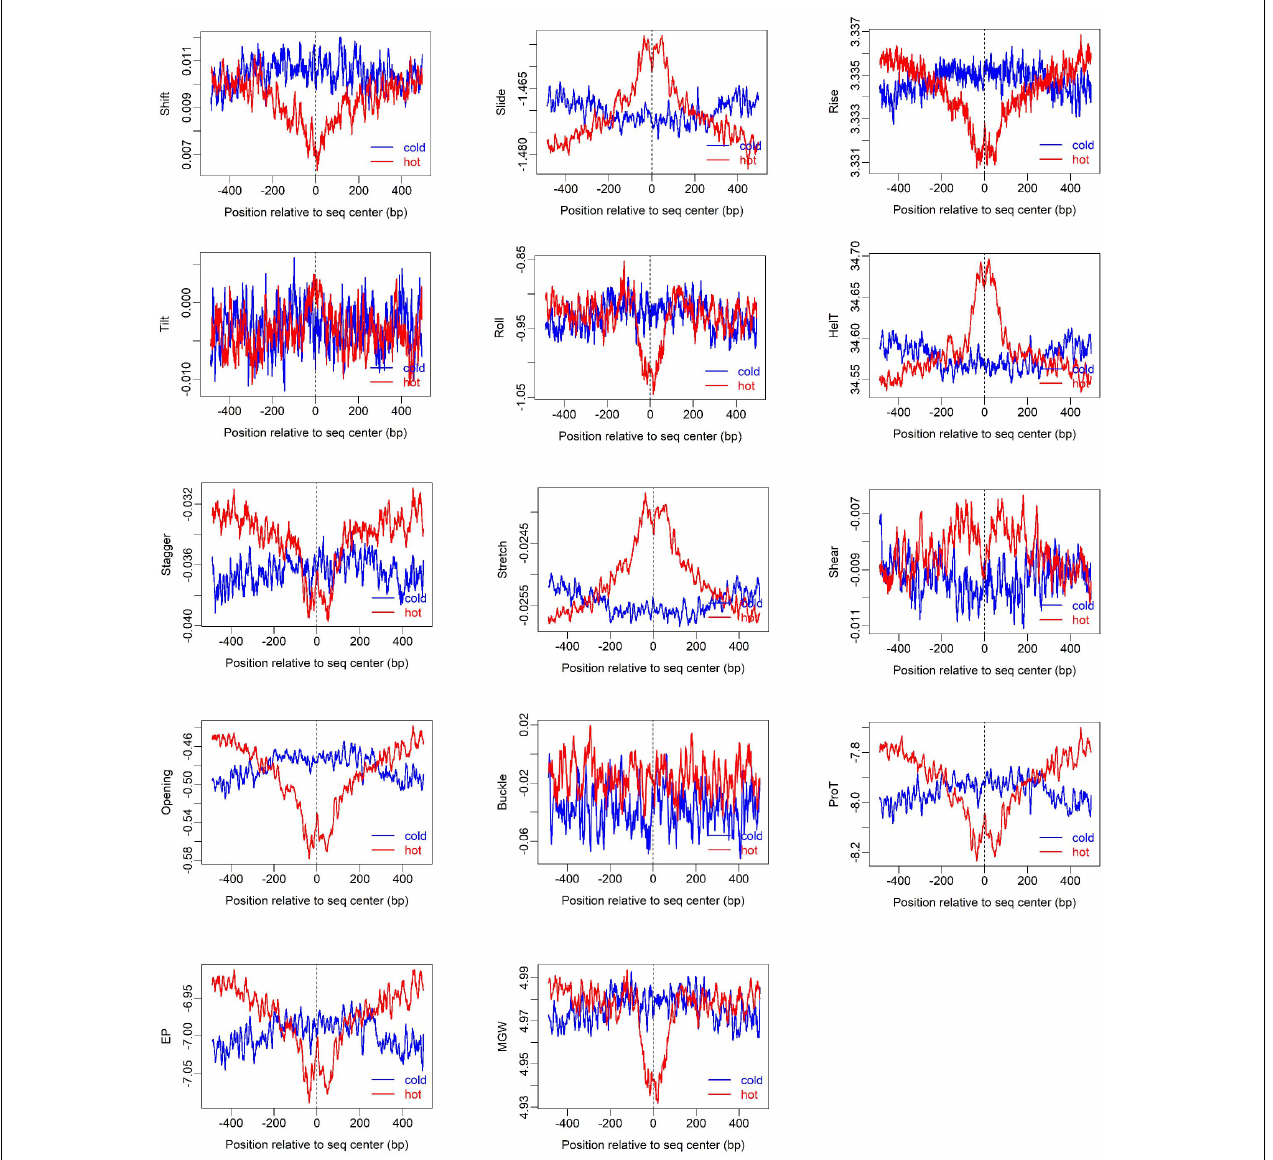
FIGURE 3 | Distribution of DNA shape and physical properties at hot/cold spots. The plots were smoothed with a 10-bp moving